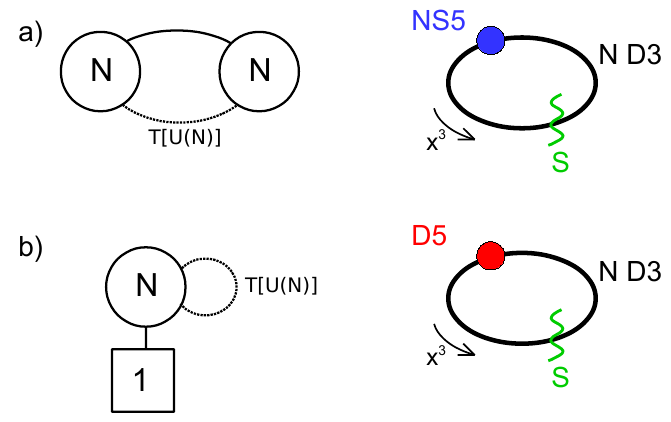
Figure 4 . a) Half-ABJM quiver and its brane realization. b) Half-ABJM mirror and its brane re-